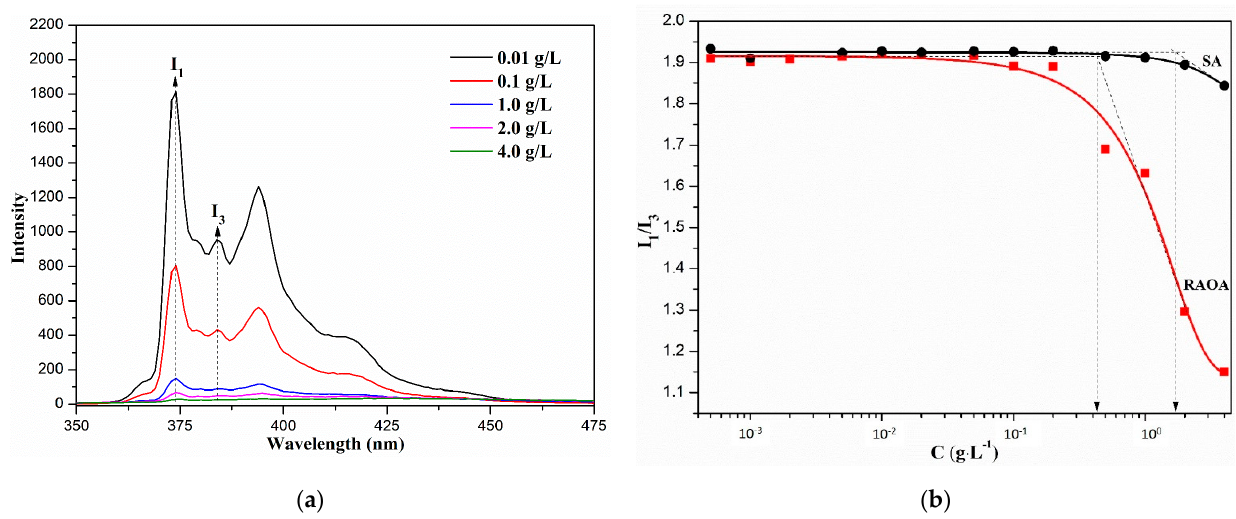
Figure 5. ( a ) Pyrene fluorescence spectra of RAOA in aqueous NaCl solution with various concentrations; ( b ) Plots of pyrene fluorescence intensity I 1 /I 3 vs. the concentration of SA and RAOA solutions.